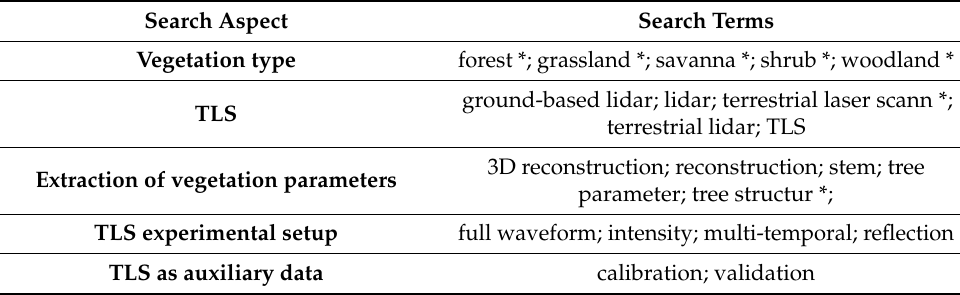
Table 1. Search terms used to build the search queries for this review. Search Aspect Search Terms Vegetation